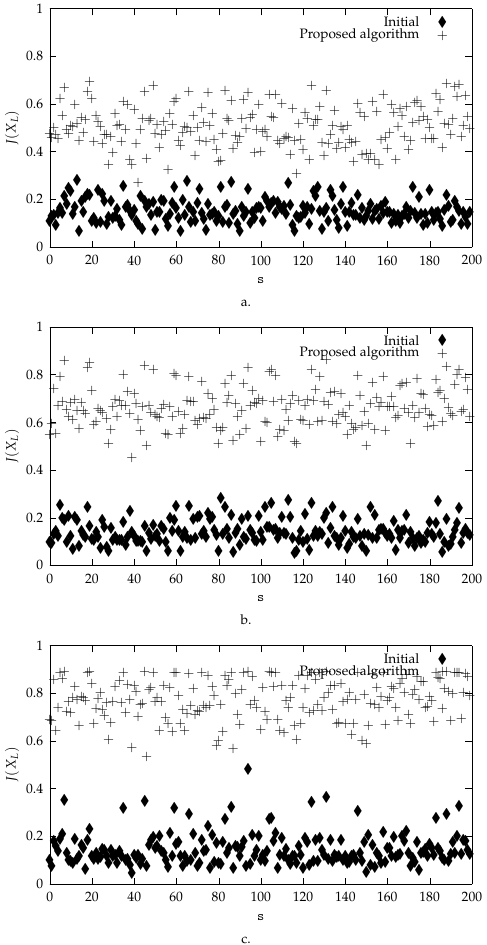
Figure 4. Jain index J ( X L ) before (Initial) and after applying the algorithm (Proposed Algorithm), for each sink node s and three different values of r c (a. r c = 0.3, b. r c = 0.4, and c. r c = 0.5).